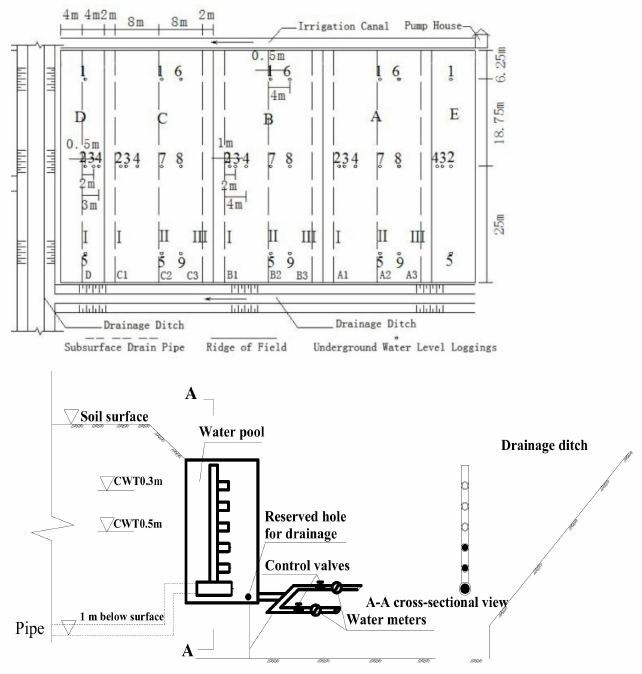
Figure 1. Schematic of the experimental field plots and control